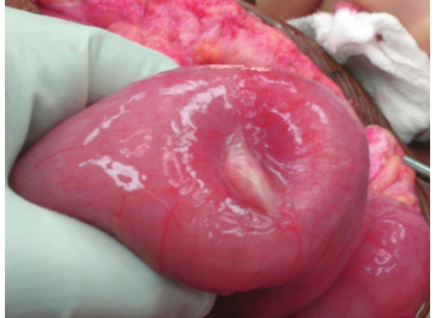
Figure 3: Suspected lead point of intussusception.